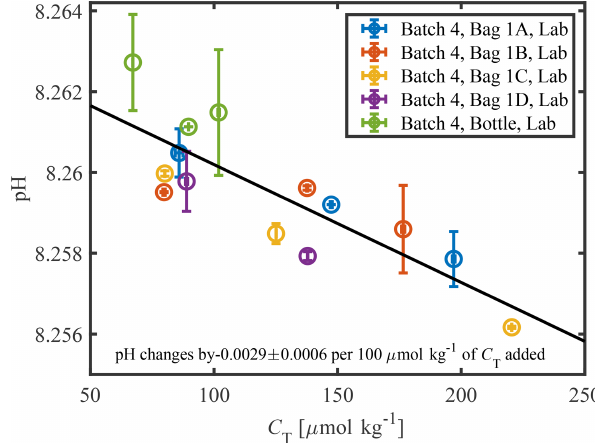
Figure 4. pH plotted against C T shows a linear relationship be- tween the two parameters in a tris buffer with a slope of − 0.0029 pH for every 100µmolkg − 1 of C T added. The measurements shown are from three sampling occurrences between 130–300d stored on bags and bottles used in Test 3. Only two measurements are shown for “batch 4, bag 1d, lab” because it ran empty before C T were